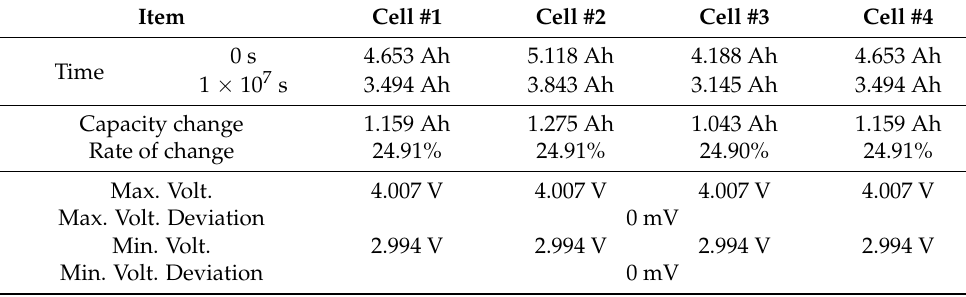
Table 2. Simulation results for single-cell charging and discharging.